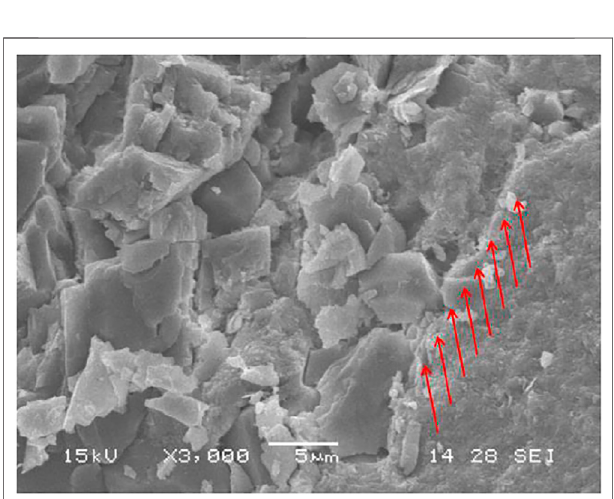
FIGURE 14 | SEM images of specimen fragments under different loading rates (grain boundary weakness).